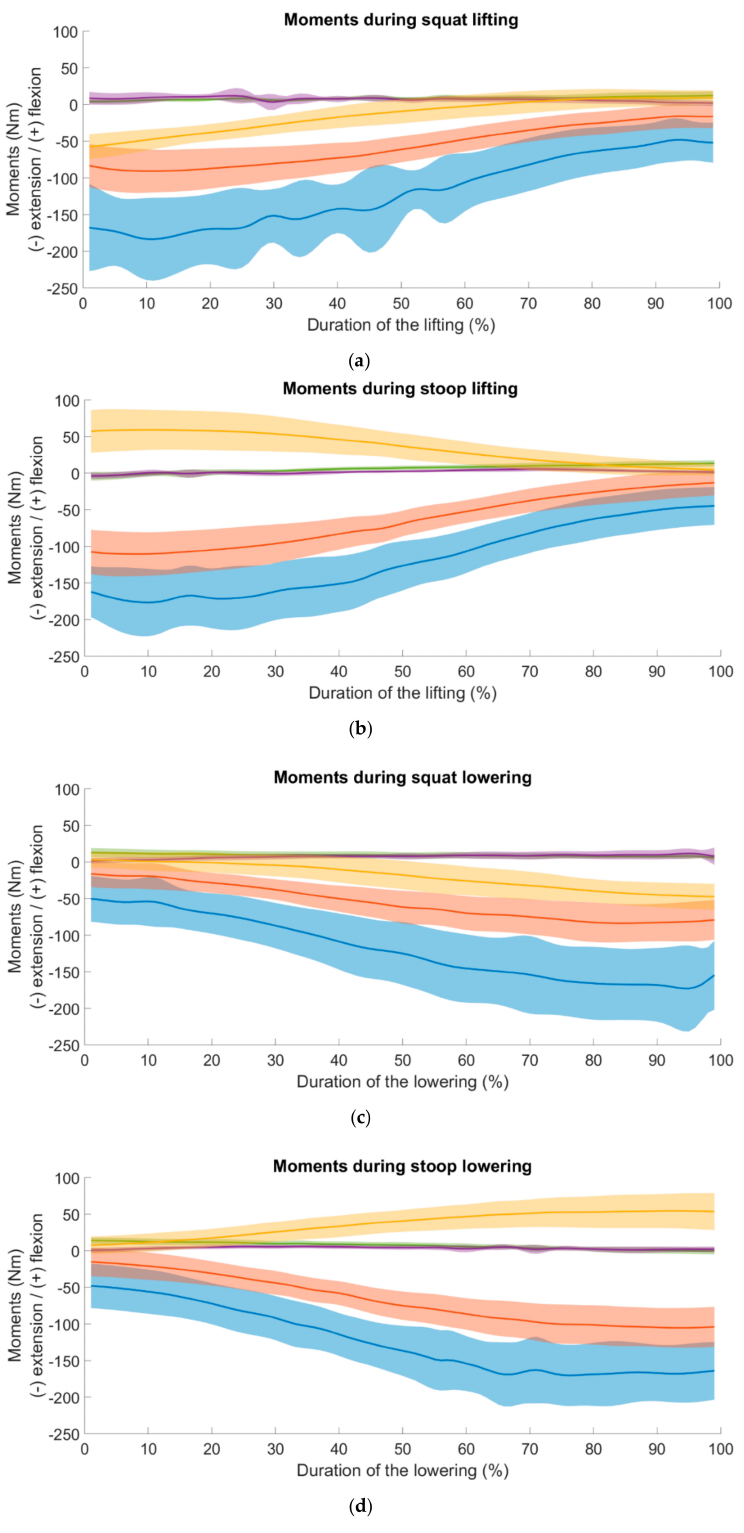
Figure 2. Moments of the five di ff erent joints (L5S1 (blue), hip (red), knee (yellow), shoulder (purple) and elbow (green)) during the two di ff erent lifting techniques (stoop and squat) with a load equal to 40% of the arm lifting strength test (40% ALST). Shaded areas indicate standard deviations. ( a ) Joint moments during squat lifting; ( b ) joint moments during stoop lifting; ( c ) joint moments during squat lowering; ( d ) joint moments during stoop